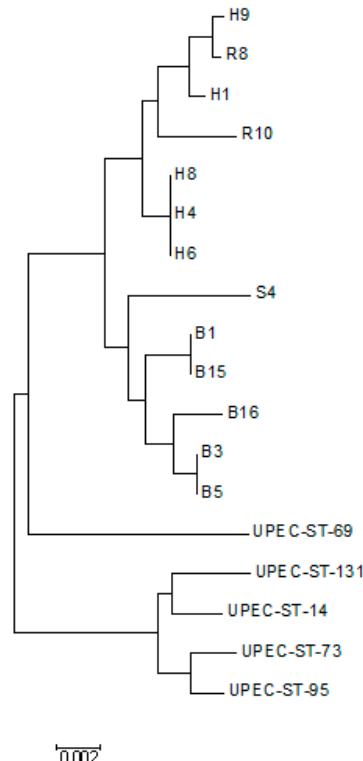
Figure 2. Molecular phylogenetic analysis by Maximum Likelihood method.